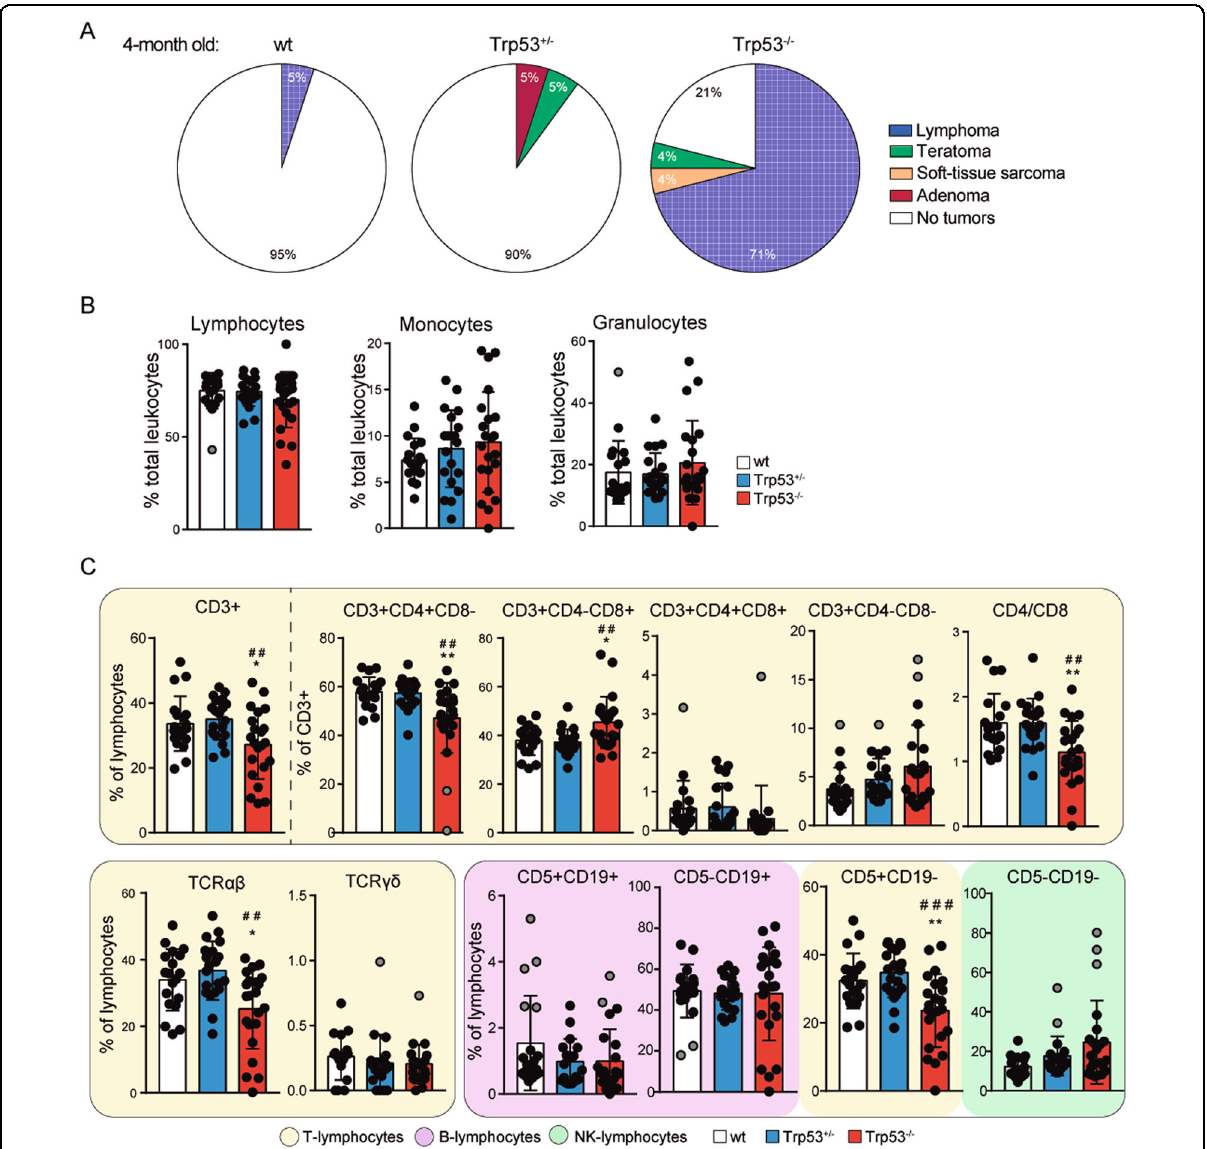
Fig. 1 Tumor spectrum and lymphocyte subsets in p53 hemizygous and p53 knockout mice. A Percentage of tumor incidence and spectrum in 4-month-old WT, p53 hemizygous (HEM) and knockout (KO) mice. B Percentage of lymphocyte, monocyte, and granulocyte populations in bloodstream of 4-month-old WT, HEM and KO mice measured by fl ow cytometry analysis. C Percentage of lymphocyte populations in bloodstream of 4-month-old WT, HEM and KO mice measured by fl ow cytometry analysis. In A , B and C , at least 20 mice per genotype were analyzed. In B and C , bars represent mean values± SEM. Signi fi cant differences and p values were derived from an unpaired t -test, two-tailed. WT vs HEM or KO: ** p value< 0.005, * p value< 0.05. HEM vs KO: ### p value < 0.0005, ## p value< 0.005. Identi fi ed outliers were represented as gray